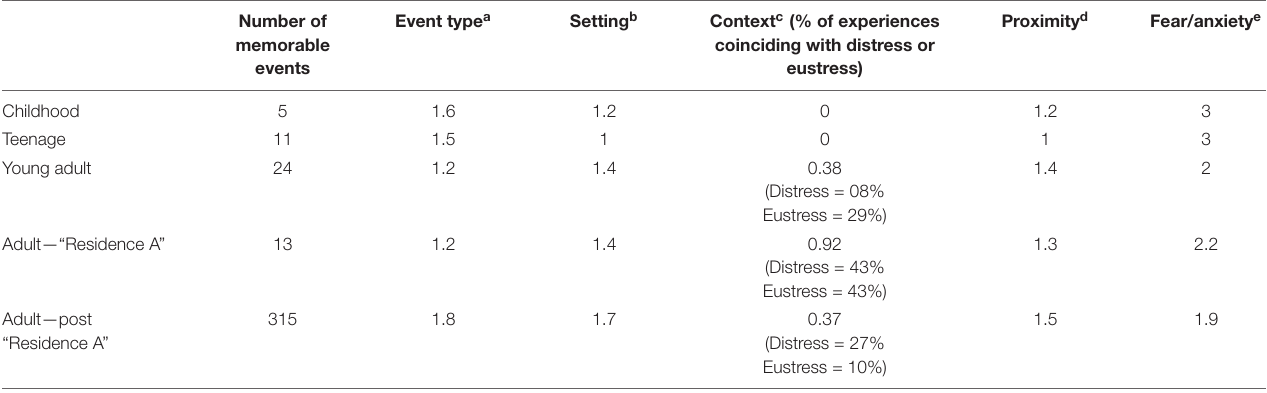
coinciding with distress or